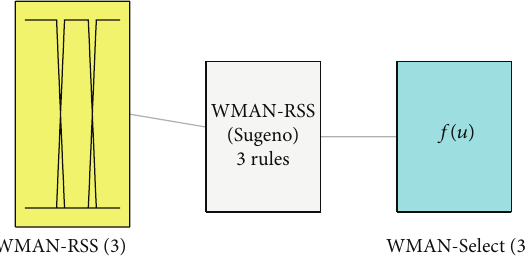
Figure 4: FLC for RSS (WMAN).